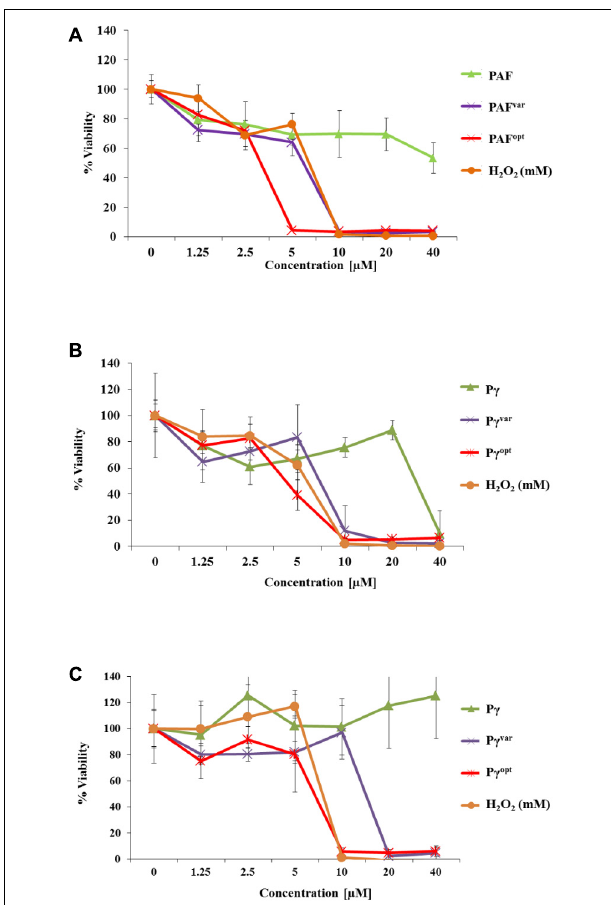
FIGURE 4 | Anti-biofilm activities of AMPs. In 96-well microtiter plates C. albicans was allowed to establish a biofilm for (A,B) 1 h and (C) 24 h before 0–40 µ M of (A) protein and (B,C) peptide variants were added. H 2 O 2 (0–40 mM) served as a positive control. Values represent the mean of three replicates. Values represent mean ±